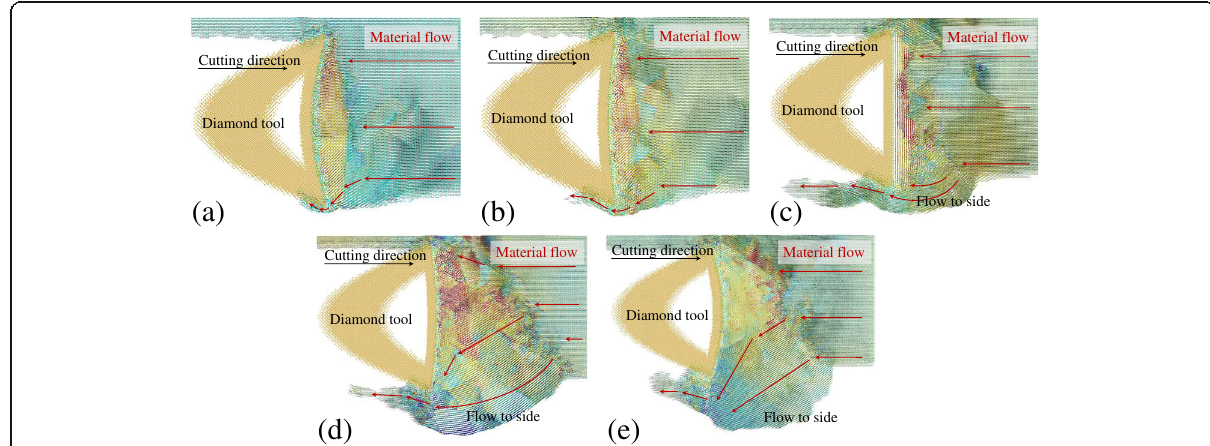
Fig. 13 Displacement vector plots at rake angle of ( a ) 30°, ( b ) 15°, ( c ) 0°, ( d ) − 15°, ( e ) − 30°